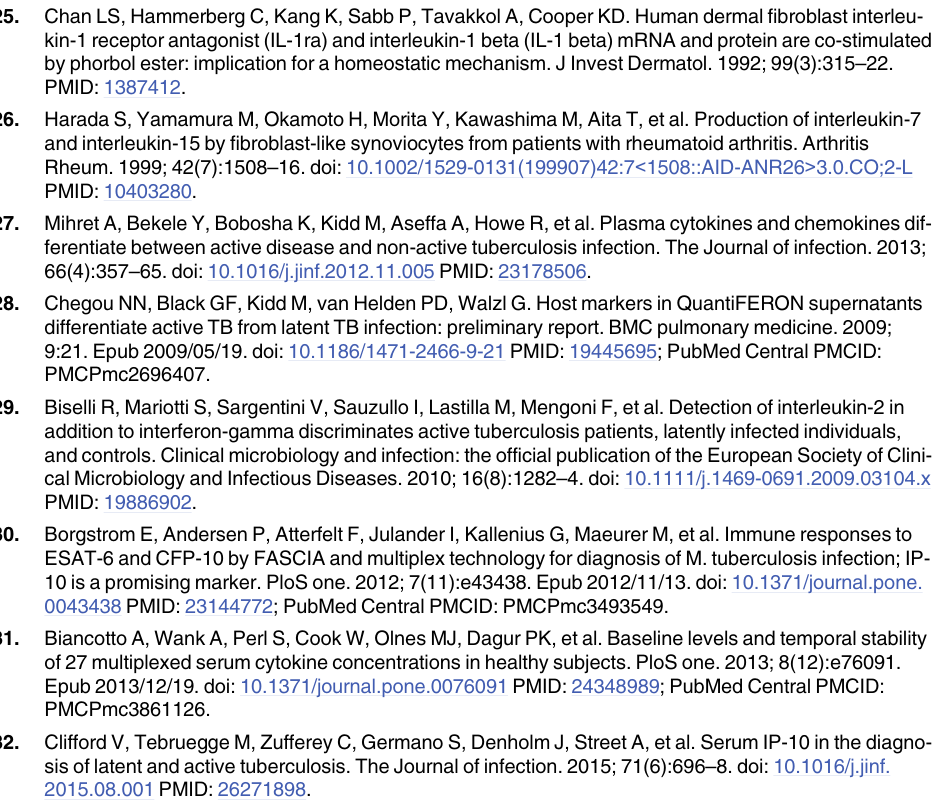
PLOS ONE | DOI:10.1371/journal.pone.0152483 April 1,